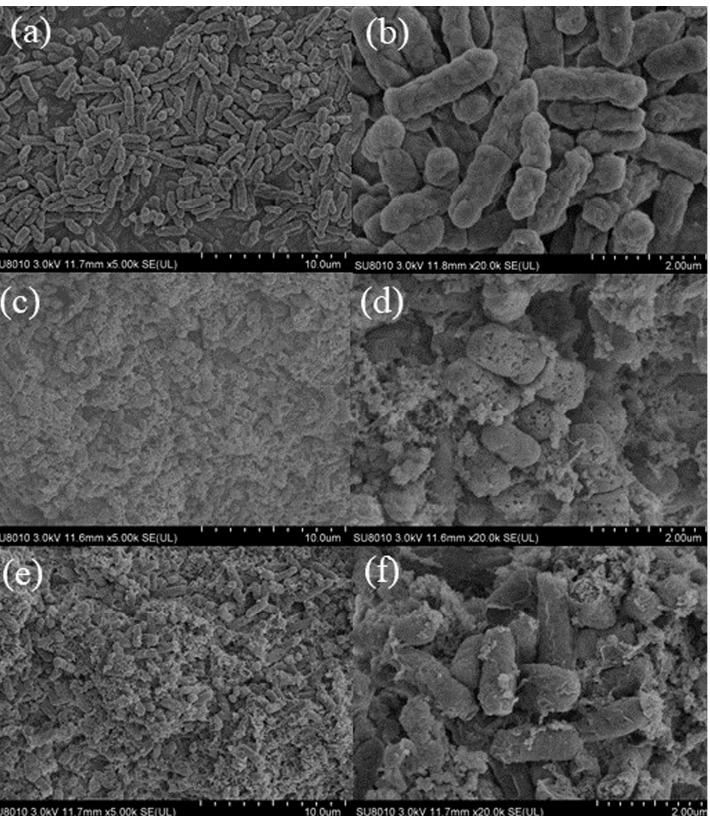
Figure 9. SEM images of E. coli treated with CBDA and CBDVA (( a , b ): control group; ( c , d ): CBDA treatment; ( e , f ): CBDVA